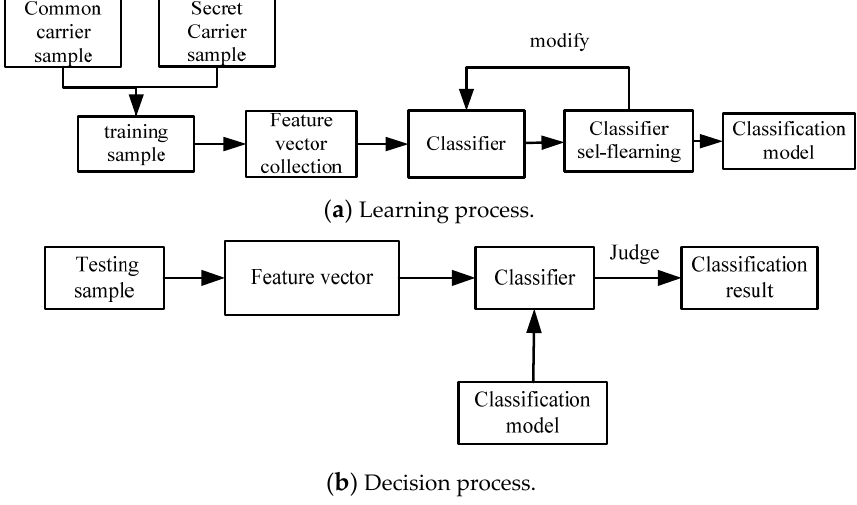
Figure 5. Support vector machine detection process.